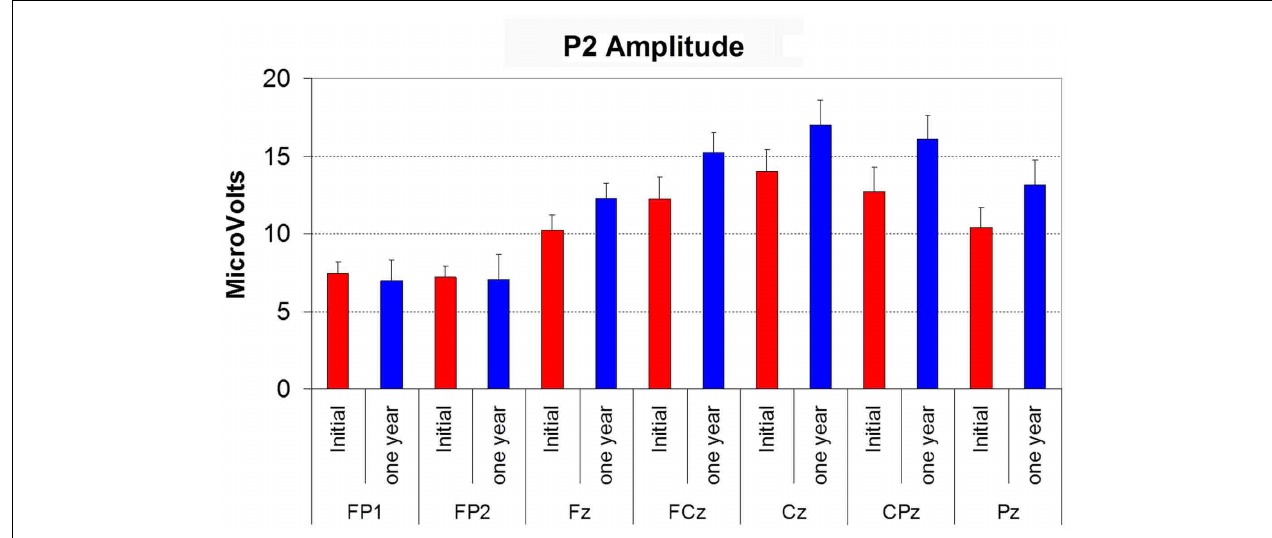
FIGURE 4 | Histogram showing the amplitude of P2 (in microvolts) at initial assessment (red bars) and at 12month follow-up (blue bars) at each electrode site. Error bars reflect